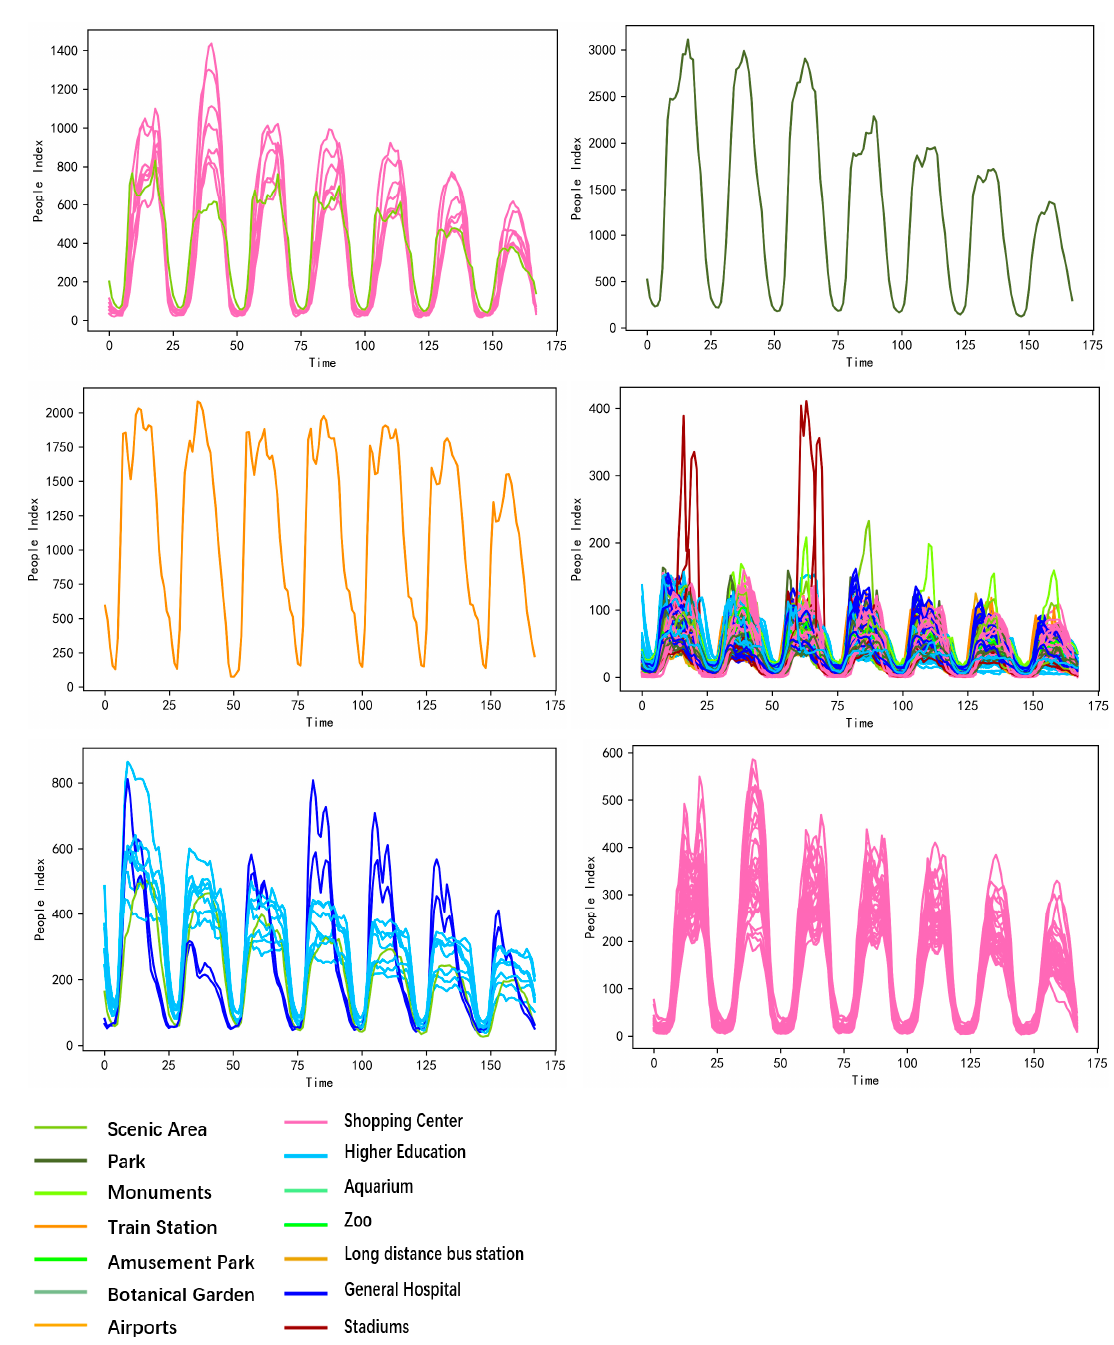
Figure 3. Clustering results of the changing patterns of pedestrian flow before the epidemic.